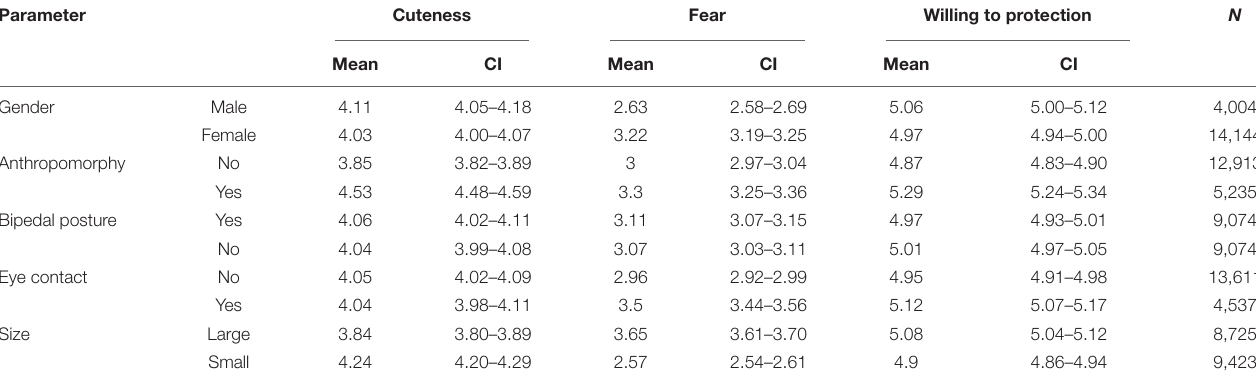
TABLE 2 | List of species used in the research. Scientific